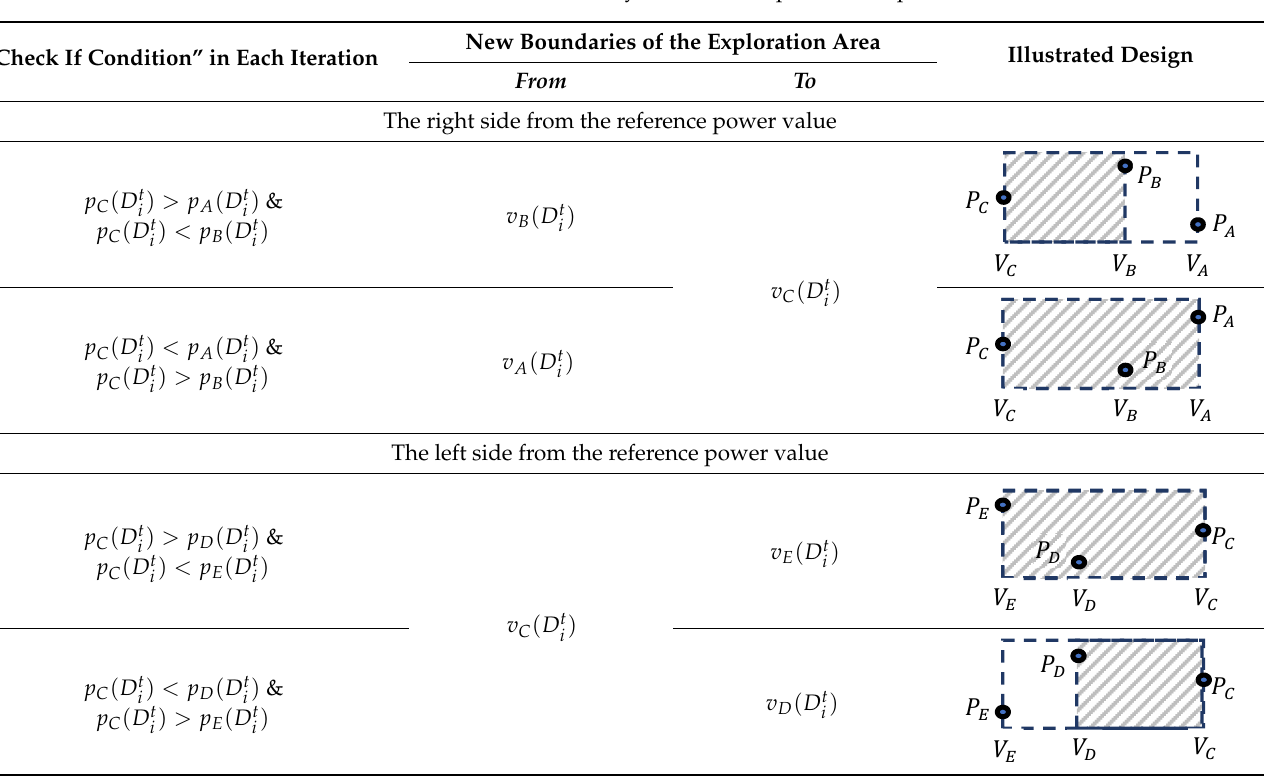
The left side from the reference power value